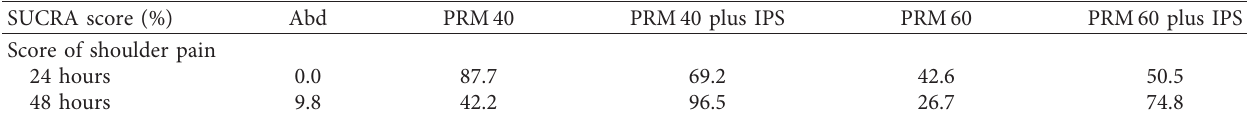
Table 2: Ranking of the interventions using SUCRA